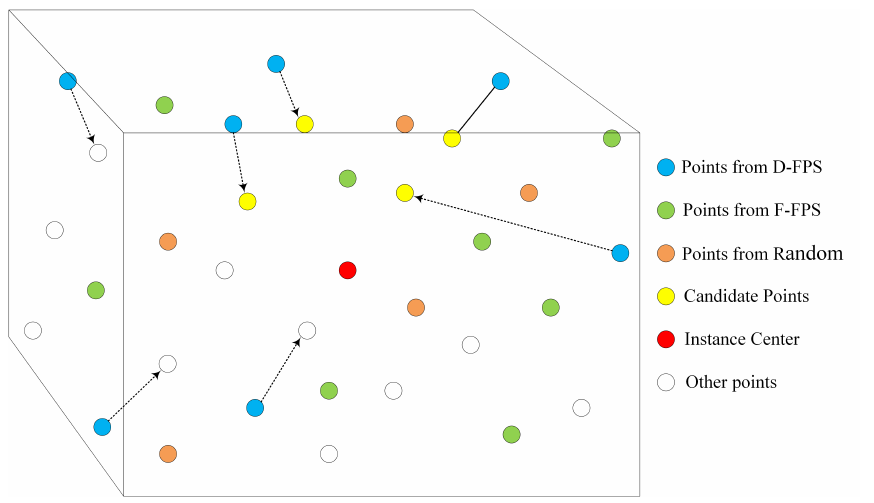
Figure 3. Hybrid sampling